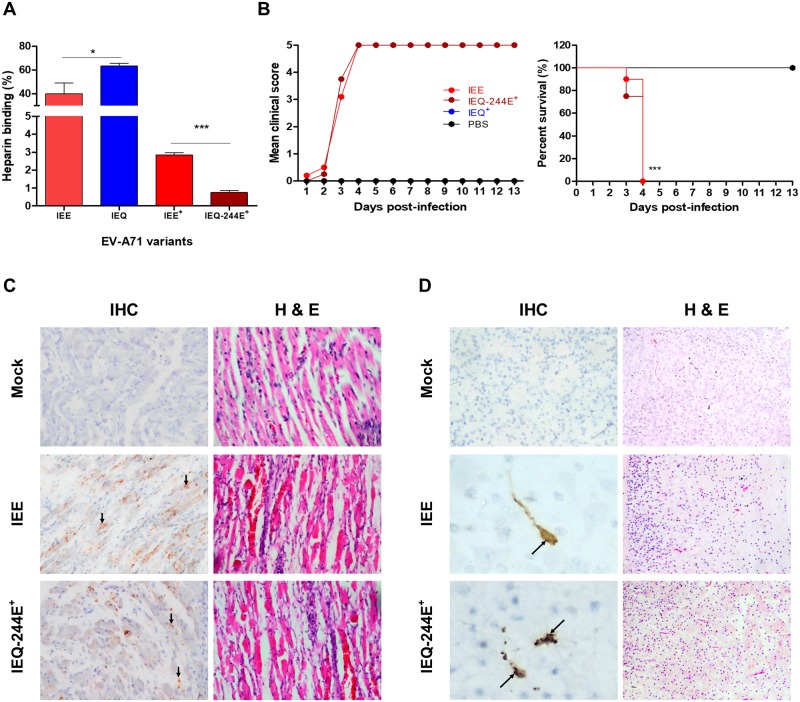
Characterization of virulent phenotype of IEE and IEQ-244E+ variants.(A) EV-A71 variants collected from the brain homogenates of dead infected mice were compared to clone-derived variants for heparin-binding properties. (B) One-day old suckling mice (n = 8–12) were infected with IEE, IEQ-244E+ and IEQ+ through i.p. injection. A control group receiving PBS injection was also included. The clinical scores and percentage of survival are shown over 13 days post-infection. Significant differences compared to WT are labelled as ** (P < 0.01) and ***P (< 0.001). Tissue samples of mice which succumbed to IEE (n = 2) and IEQ-244E+ (n = 2) infection were subjected to IHC and H&E staining. Virus antigen was seen in muscle cells (C), along with increased inflammatory infiltrates. In brains (D), antigen-positive neurons were seen in the pons (representative image from an IEE-infected brain) and dentate nucleus (representative image from an IEQ -244E+-infected brain), with mild inflammation in the cortex shown by H&E staining. Magnification for IHC staining: X40; H&E staining: X20.